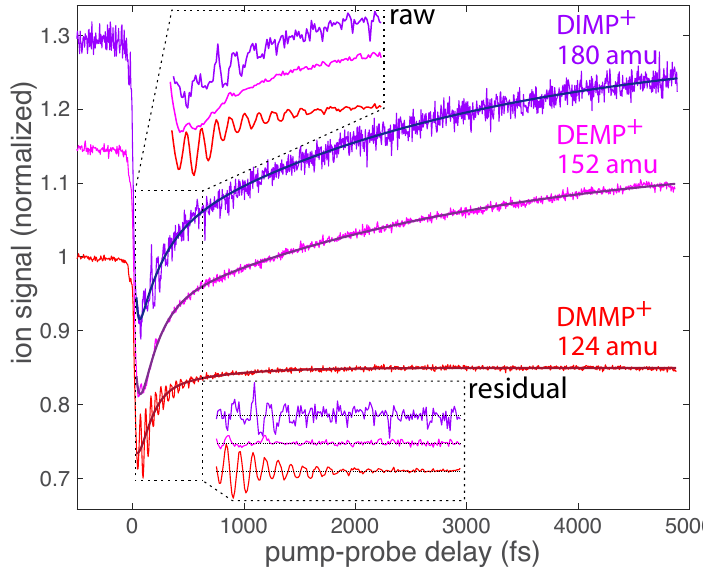
Figure 2. Transient ion signals of the parent molecular ions of DMMP (red), DEMP (magenta), and DIMP (violet) as a function of pump–probe delay. The region between 30 and 700 fs is magnified in the insets to show the oscillations. The dark solid lines denote fits to Equation